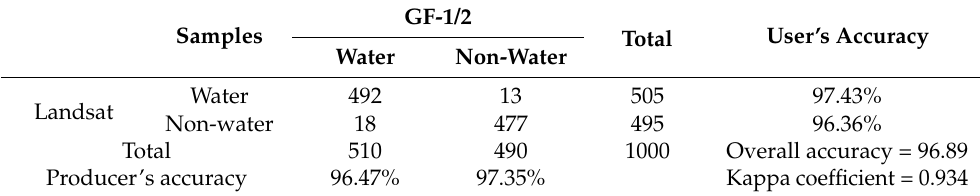
Table 2. The confusion matrix for accuracy assessment.